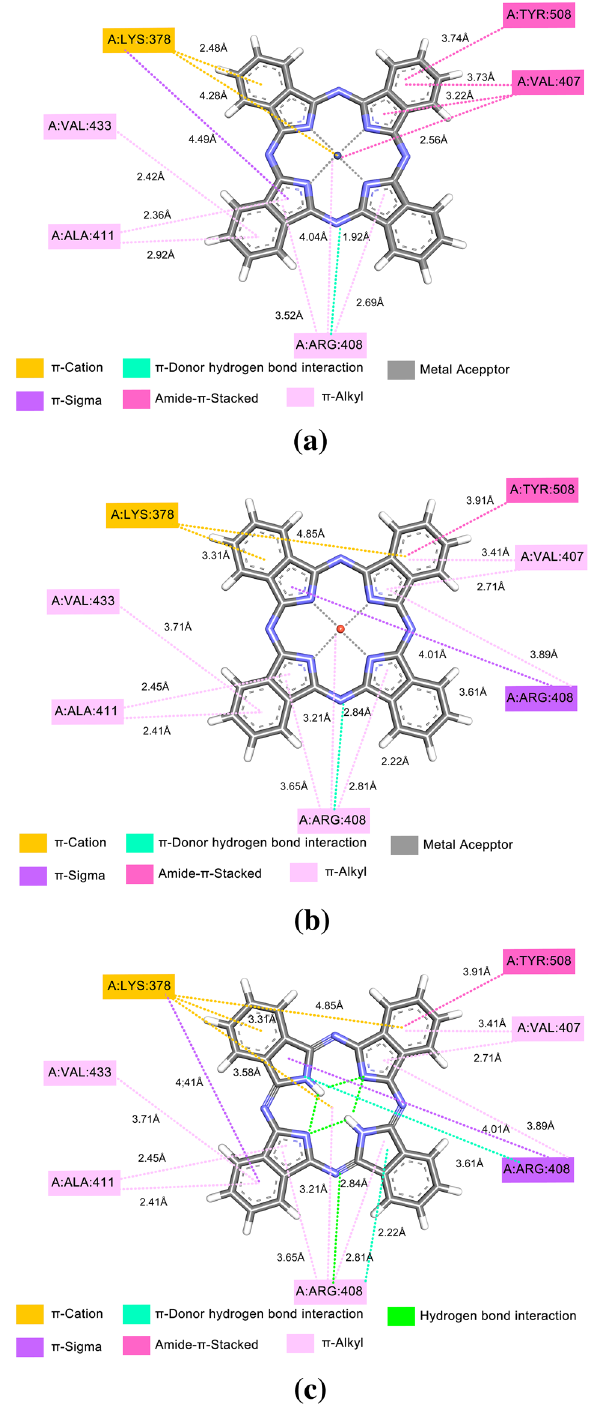
Figure 5. S-gly with: ( a ) CoPc, ( b ) CuPc, e ( c )